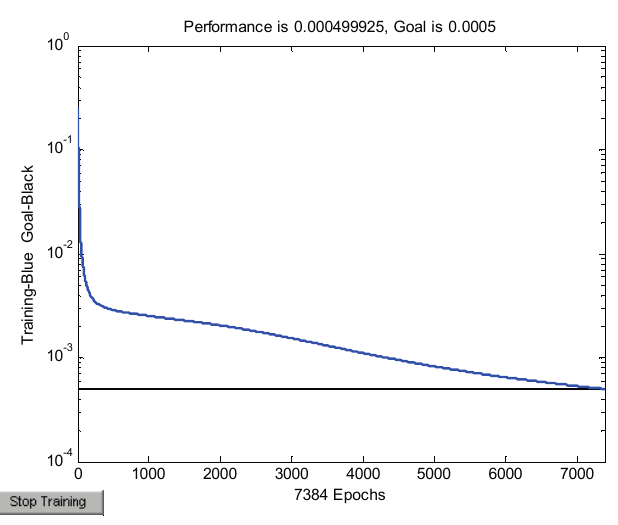
Figure 9. The training error in the neural network.